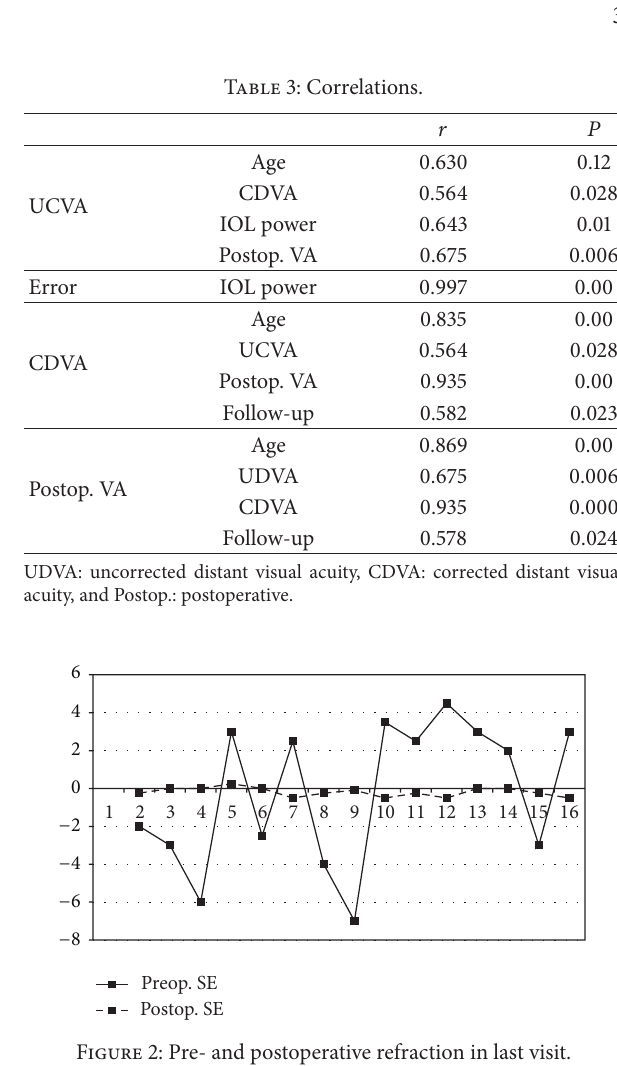
Preoperatively, mean log MAR UDVA was 0.875 ± 0.22 (range: 0.30 to 1.18) and mean log MAR CDVA was 0.186 ± 0.13 (range: 0.00 to 0.48). All patients had improved UDVA postoperatively.